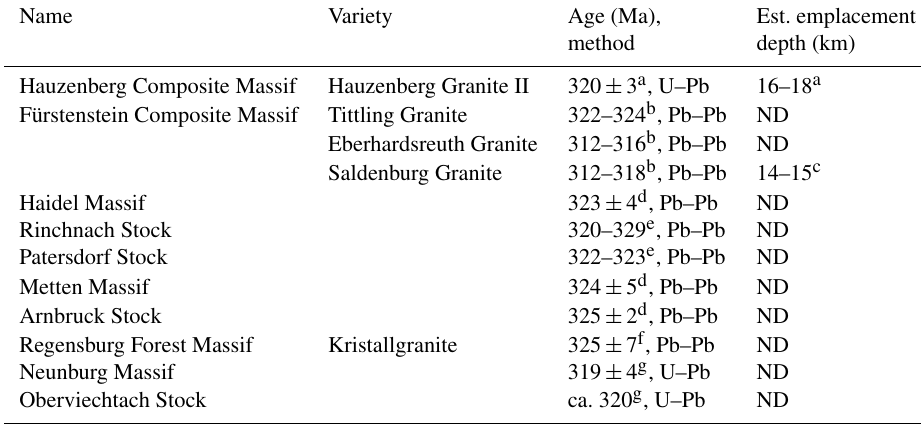
Table 1. Ages and estimated emplacement depths for granites along the southwestern Bohemian Massif. All ages have been measured on zircons. For granite locations, see Fig. 3.